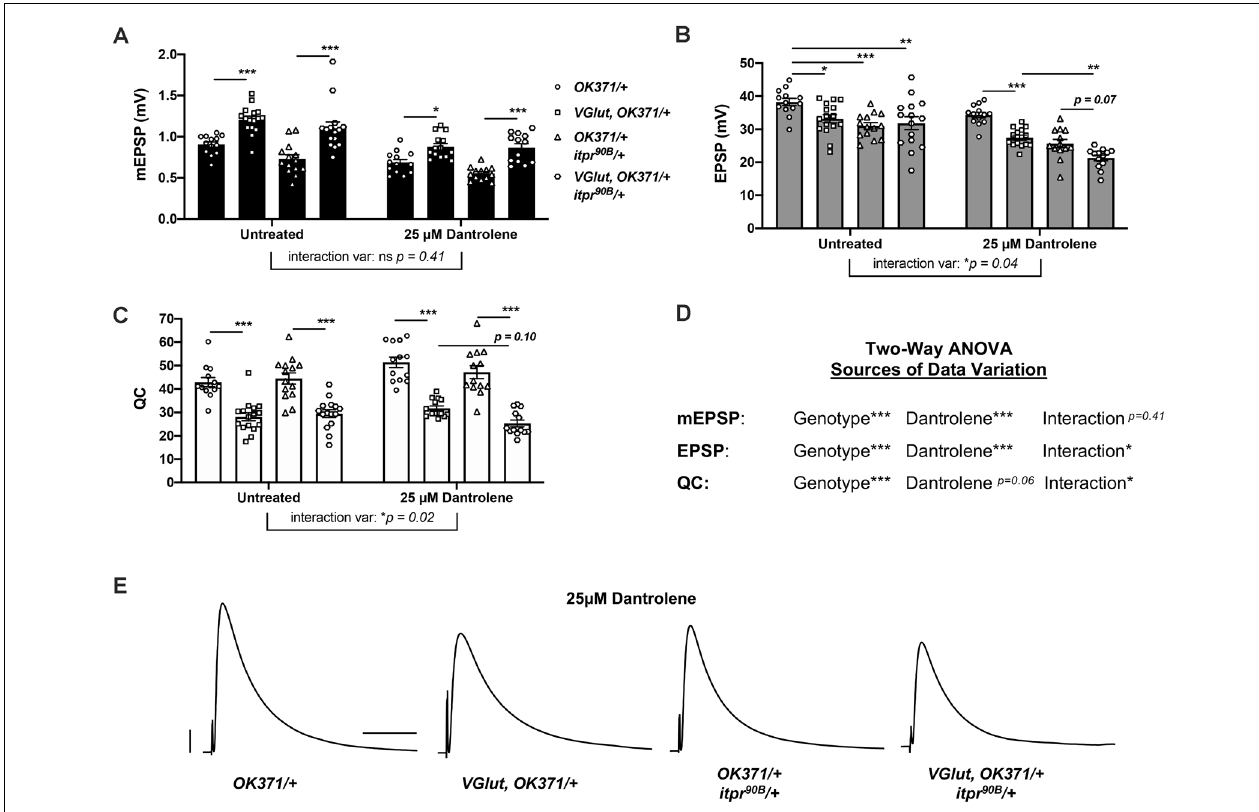
FIGURE 5 | Genetic impairment of itpr combined with pharmacological impairment of RyR phenocopies genetic findings. Notes: Untreated data for OK371/+ and VGlut, OK371/+ are repeated from Figure 1 , for genetic background comparison, and analyses are by two-way ANOVA with Tukey’s post-hoc to account for genotype effects, 25 µ M Dantrolene effects, and interaction effects between genotype and Dantrolene. (A) Raw data for mEPSPs. (B) Raw data for EPSPs. (C) Raw data for QC. For (A–C) , bars are averages and error bars are ± SEM, with individual datapoint shapes corresponding to genotype. (D) Two-way ANOVA analysis of the effects of each parameter on data variation for each electrophysiological measure. * p < 0.05, ** p < 0.01, and *** p < 0.001 by two-way ANOVA with Tukey’s post-hoc . (E) Representative EPSP traces. Scale bars are as in Figure 1 .